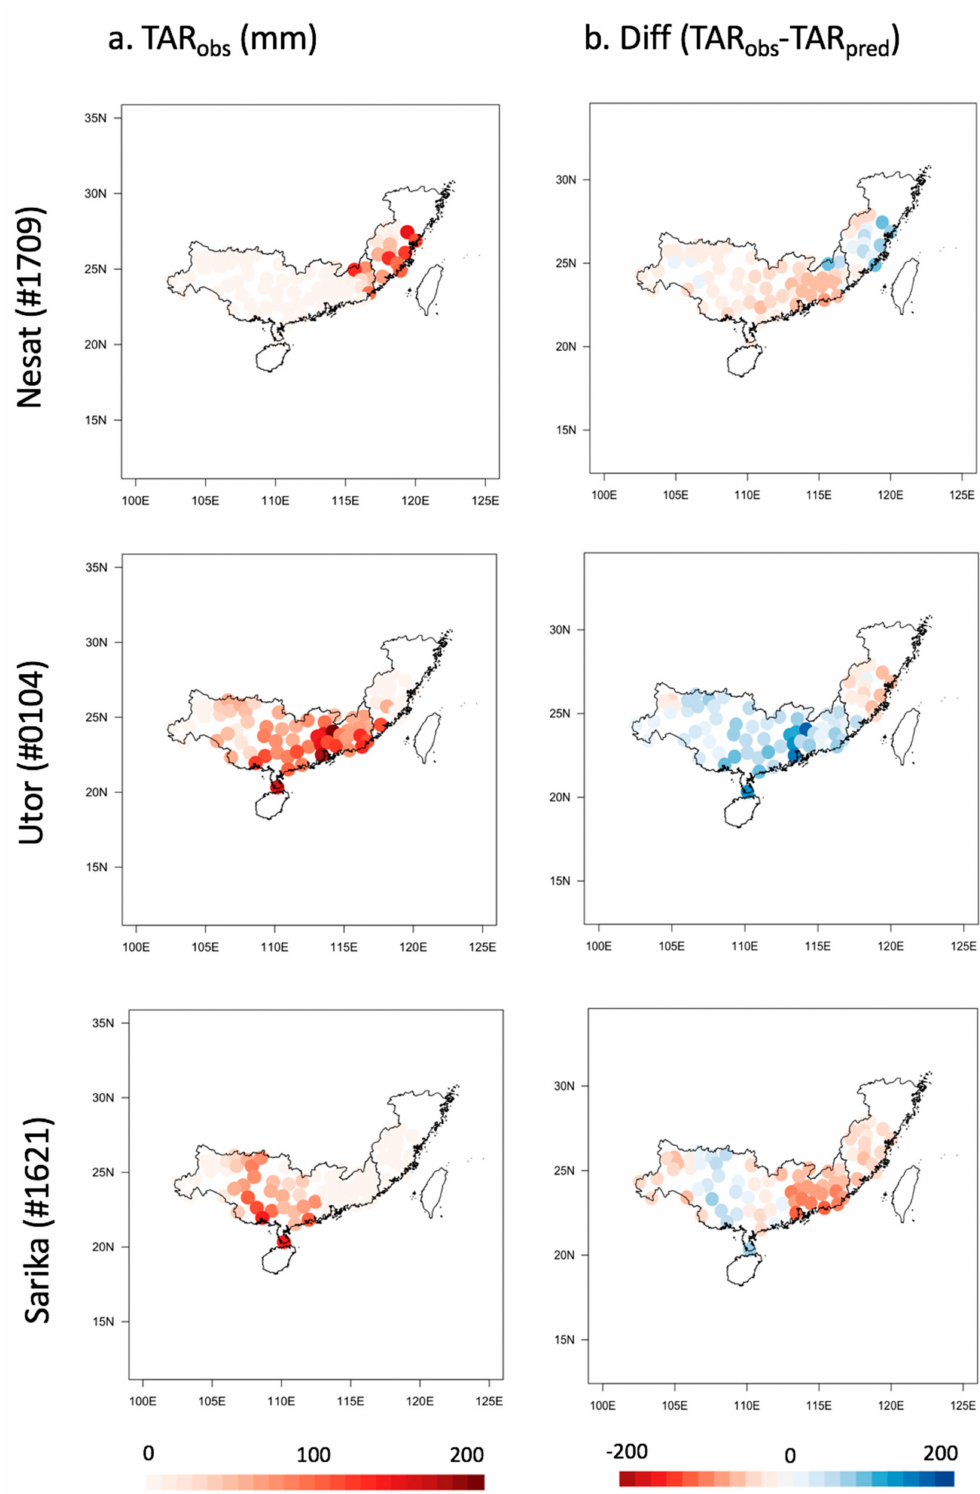
Figure 7. TAR estimation at 75 stations along the southern and southeastern coasts of China for typhoons Nesat (#1709), Utor (#0104), and Sarika (#1621): ( a ) the observed values; and ( b ) the di ff erence between observed and predicted